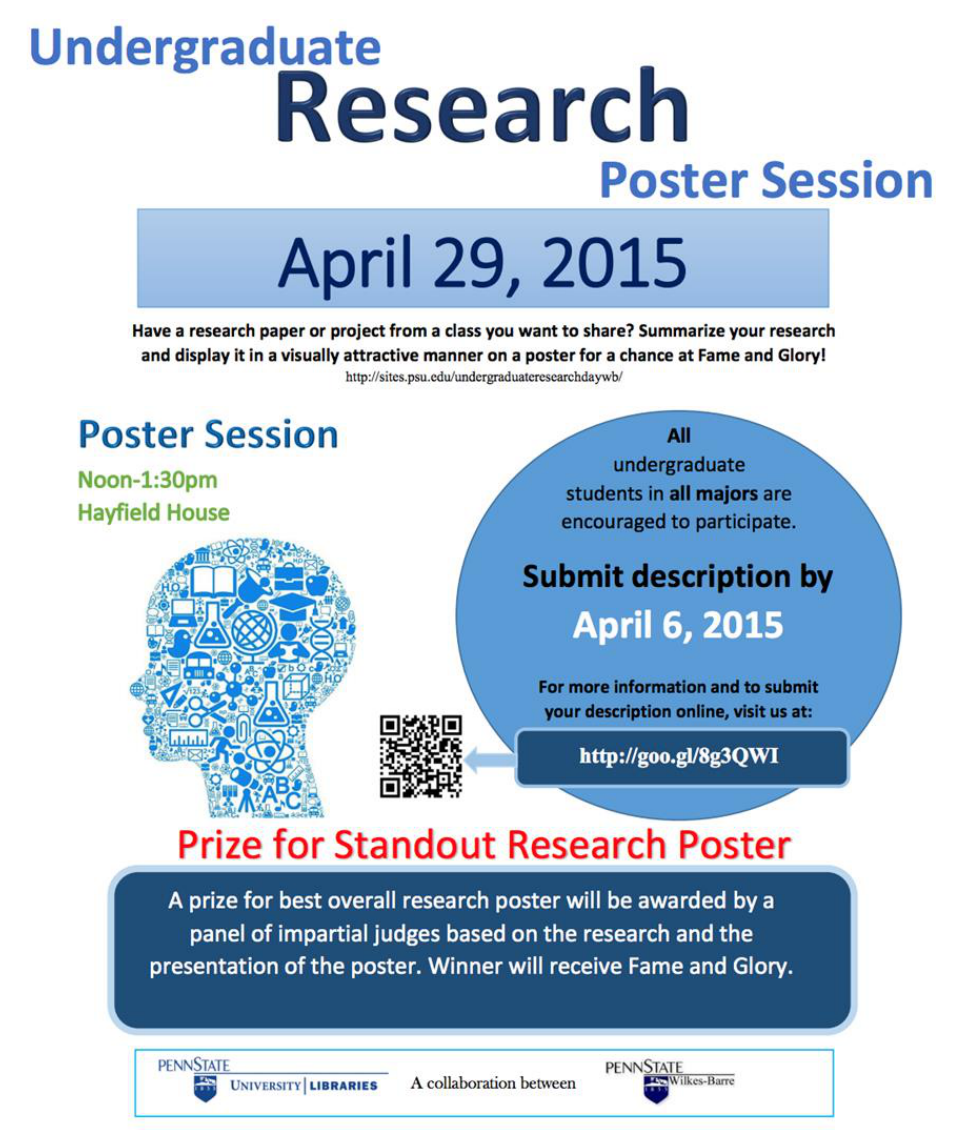
Original poster advertising Undergraduate Research Day. This poster was placed in prominent locations around campus and distributed via email to all faculty and